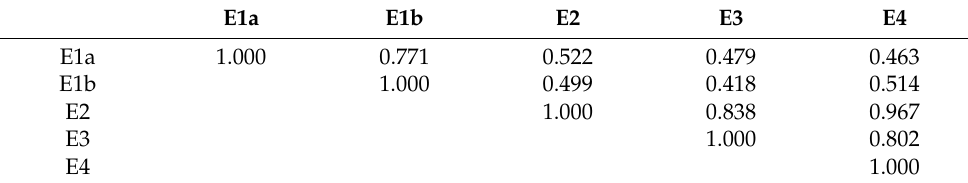
Table 6. Pearson’s correlation coefficients between each experts’ calculated criteria importance